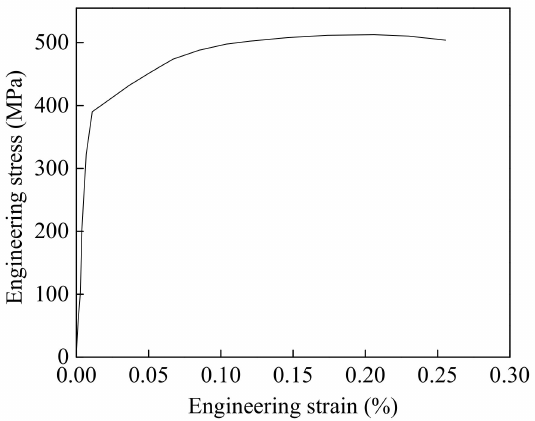
Figure 4. ER70s-6 properties test specimen: ( a ) surfacing sample, ( b ) tensile sample.